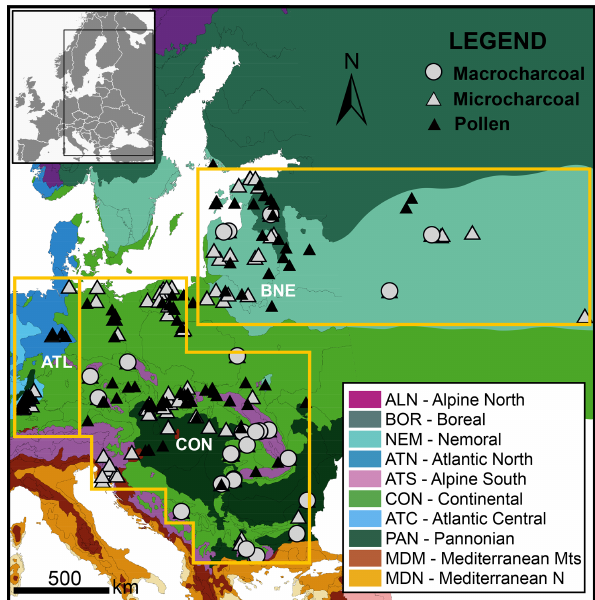
Figure 1. Map showing the distribution of main environmental zones in central and eastern Europe (Metzger et al., 2005). Filled tri- angles and circles show the location of charcoal and pollen records. Orange rectangles denote the ecoregions analysed in this study: At- lantic (ATL), continental (CON) and boreo-nemoral